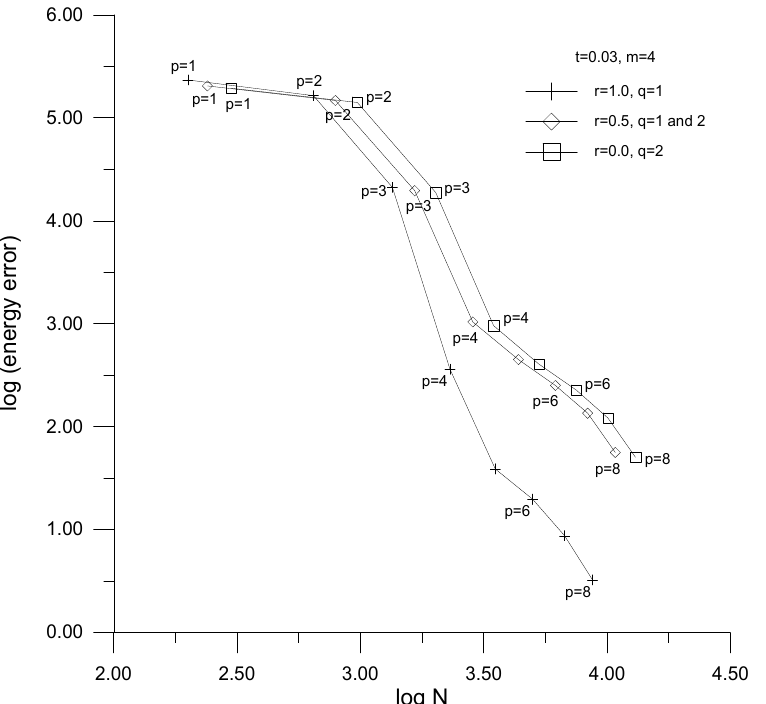
Figure 23. Convergence curves—the bending-dominated shell with the classical transition elements.